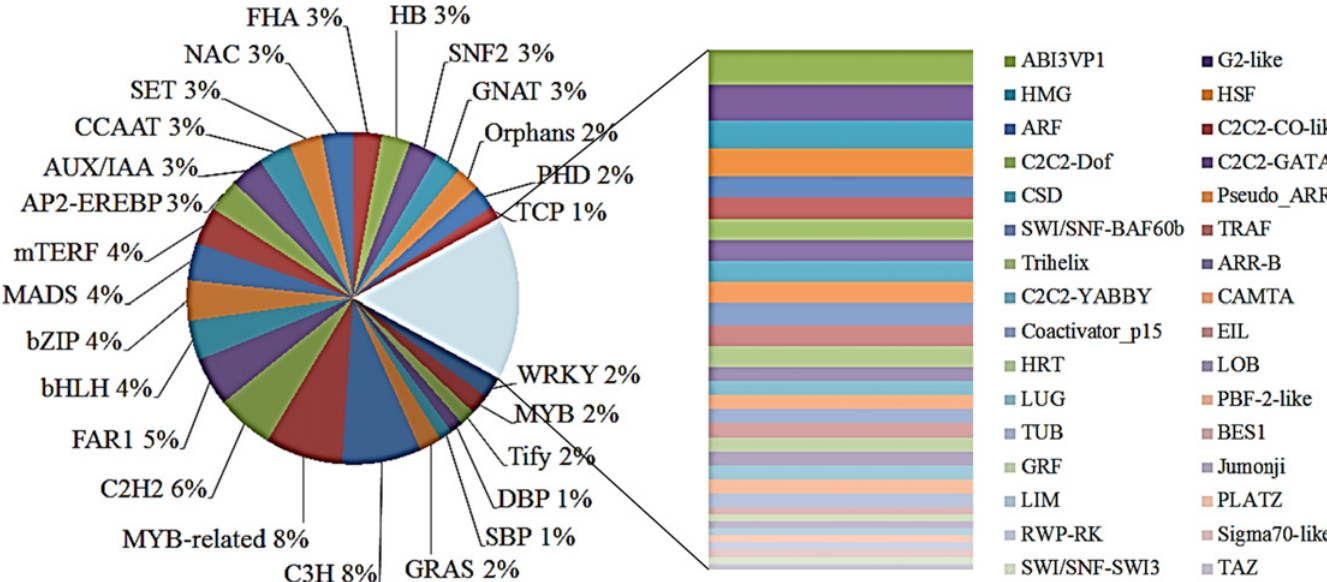
Fig 5. Enrichment of transcription factor genes and classification of TF families. TF genes were classified into TF families using blast against the publicly available Plant Transcription Factor Database (PlnTFDB); the 464 TF genes were classified into 58 TF families. Numbers represent the percentage of TF families out of the 464 TF genes. The classification and annotation of all TF genes with respect to functional categories and transcription factor families are presented in S9 Table.